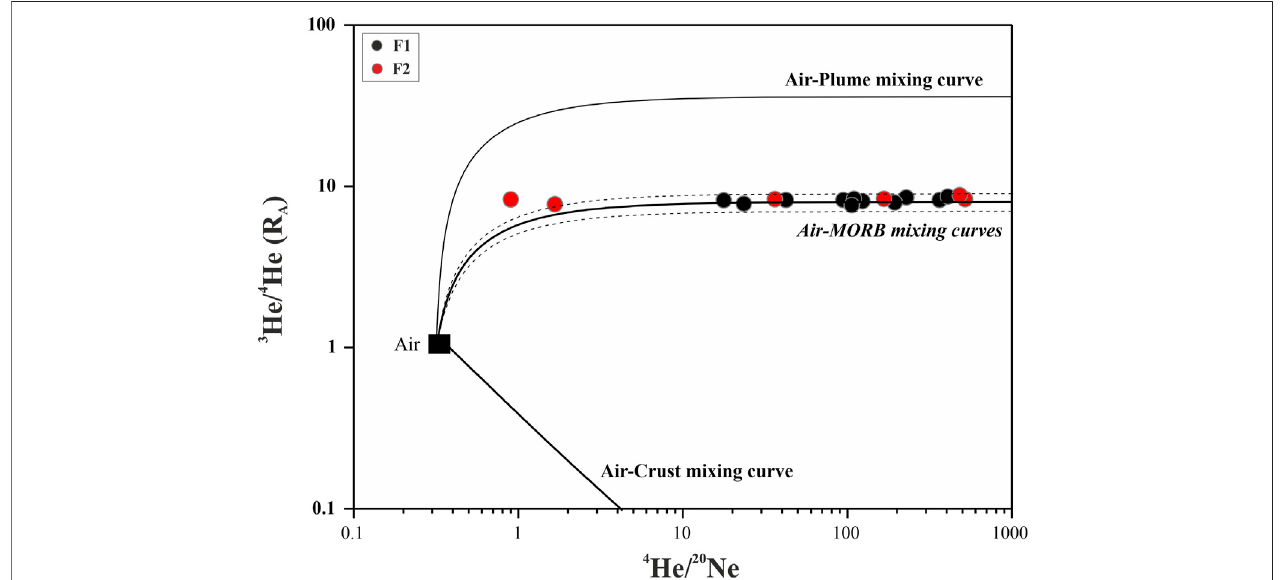
FIGURE7| 4 He/ 20 Neratiosand 3 He/ 4 He(R A )ratiosobservedinPicodoFogofumarolesamples.Airhas 3 He/ 4 Heof1xR A and 4 He/ 20 Neratiosof0.318(Ozimaand Podosek, 2002). Curves represent theoretical mixing lines between air and other end-members.